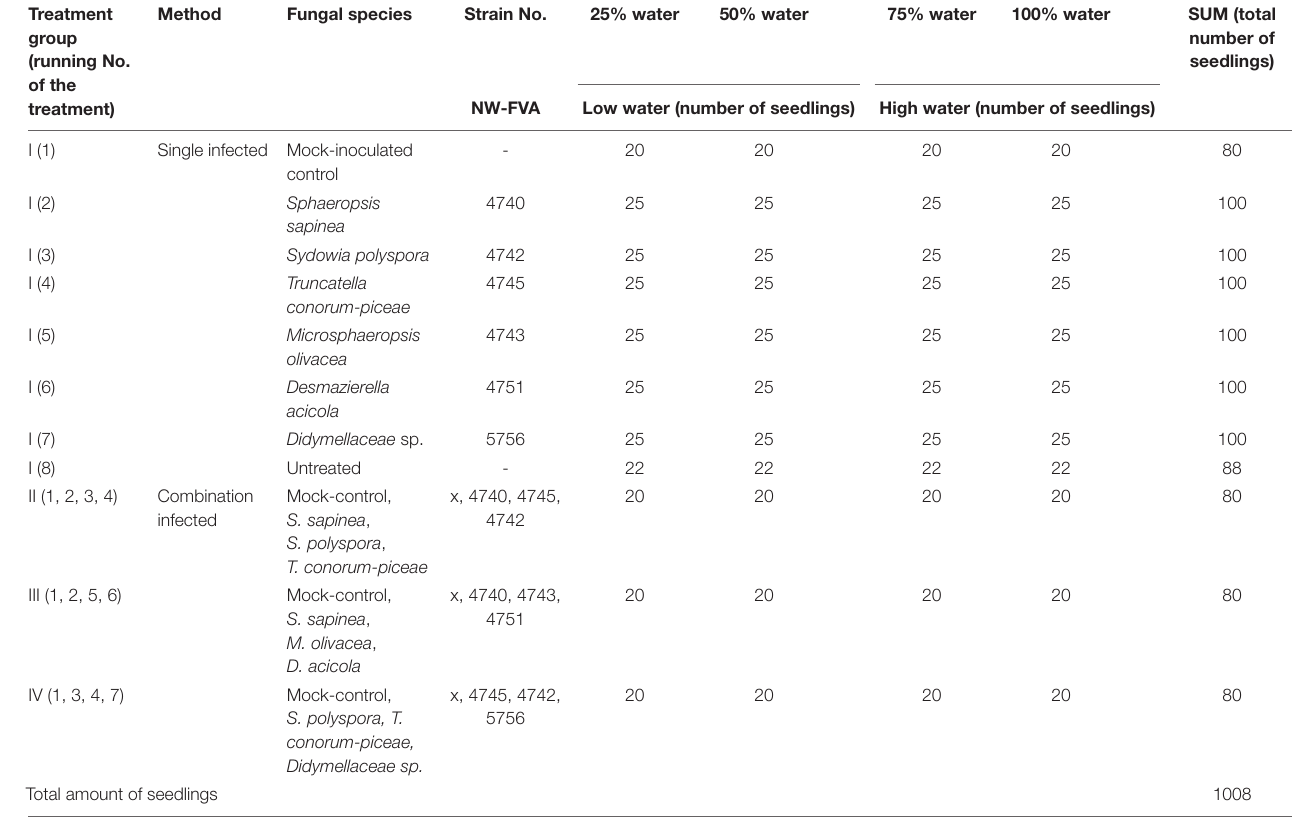
Sy. polyspora ( Figure 4A ), M. olivacea ( Figure 4B ), T. conorum- piceae ( Figure 4C ), and D. acicola ( Figure 4D ) were chosen for inoculation studies because of their frequent endophytic occurrence in P. sylvestris